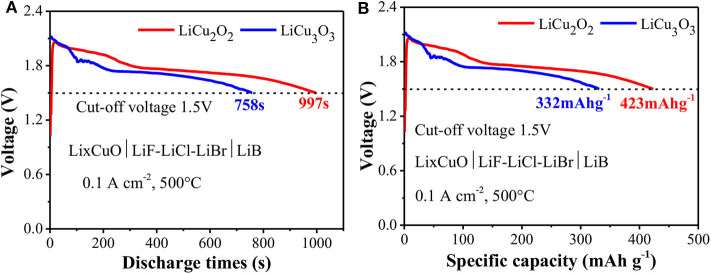
The discharge curves of LiCu2O2
(A) and LiCu3O3
(B).